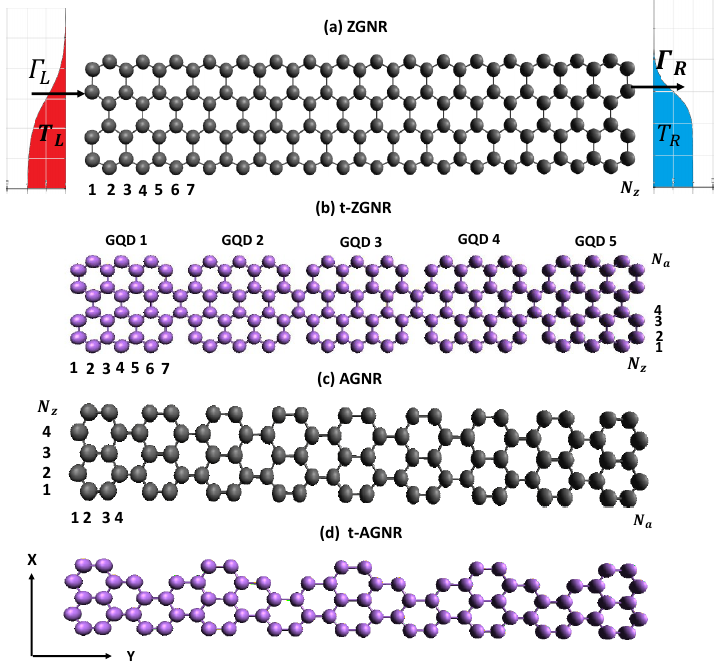
Figure 1. Schematic diagrams of ( a ) ZGNR, ( b ) textured-ZGNR (t-ZGNR), ( c ) AGNR, and ( d ) t-AGNR. In ( a ), we also show the electrodes with Γ L ( Γ R ) denoting the tunneling rate of the electrons between the left (right) electrode and the leftmost (rightmost) atoms of the ZGNR. T L and T R denote the temperature of the left ( L ) and the right ( R ) electrodes, respectively. Note that t-ZGNRs can be formed by periodically removing some carbon atoms on the zigzag edges of ZGNRs. In ( b ), the t-ZGNR consists of GQDs with size characterized by ( N a , N z ) = ( 8,7 ) . In ( c ), the AGNR has a length N a = 36 and width N z = 5. In ( d ), the width and length of the unit cell for the t-AGNR superlattice are characterized by N z = 5 and N a = 8,